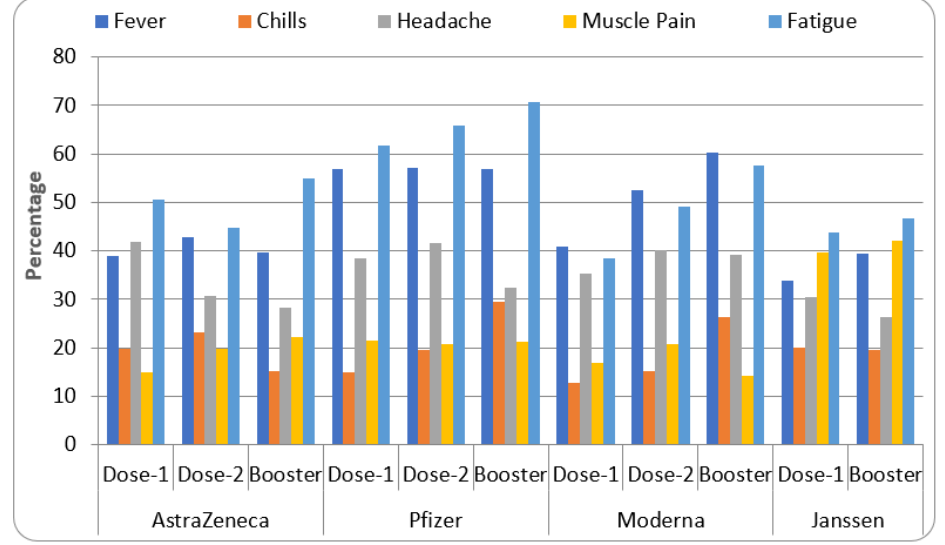
Figure 4. Common system reactions after COVID-19 vaccination.